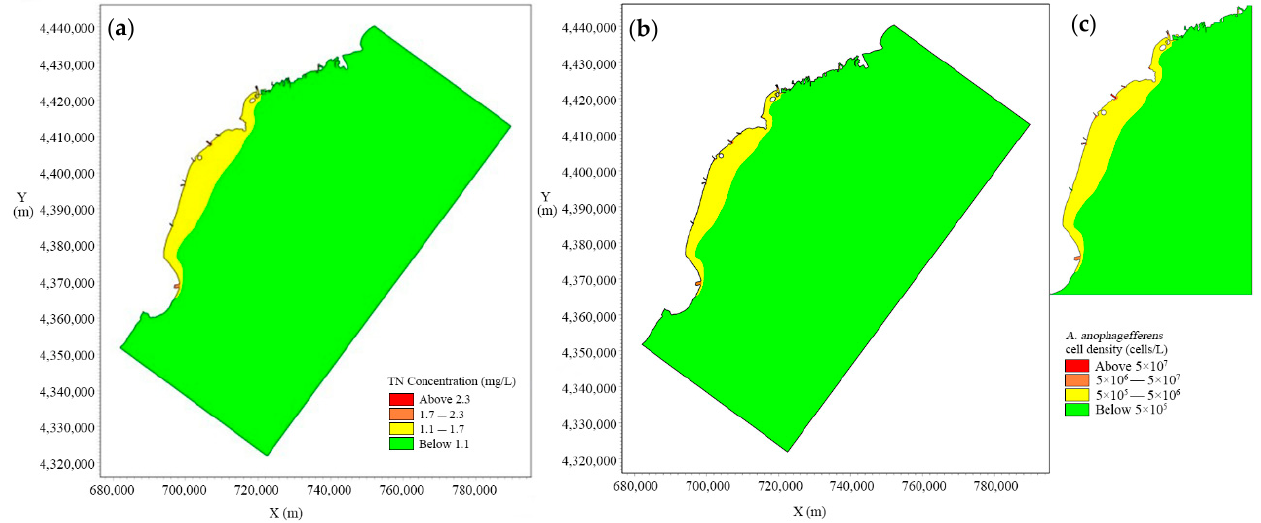
Figure 11. ( a ) The distribution of TN concentration in August 2014; ( b ) the transformation results from TN concentration to A. anophagefferens cell density, and amplification of the bloom area ( c ).